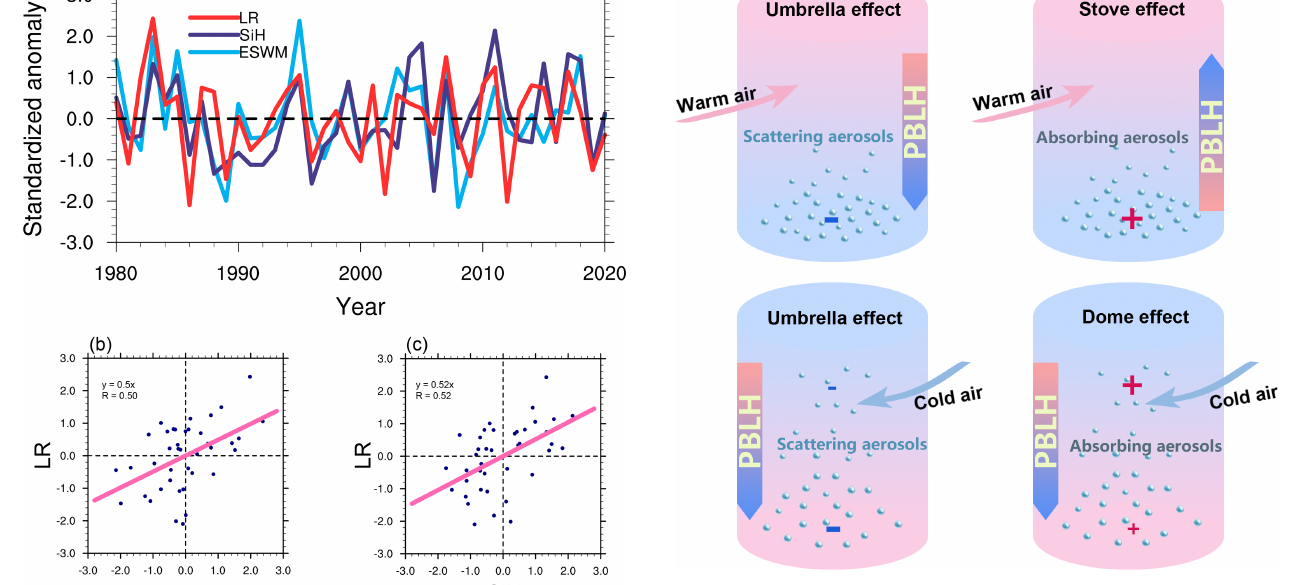
Figure 16. The illustration of the umbrella, stove, and dome effects of the scattering and absorbing aerosols under different synoptic patterns. The red plus and blue minus signs indicate the aerosol heating and dimming effect, respectively. The upward and down- ward arrows denote the increase and decrease in PBLH caused by ARE,